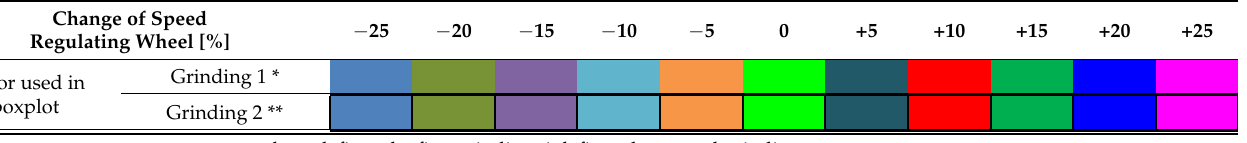
Table 6. Quarterly range percentage value x 0.75 − x 0.25 .